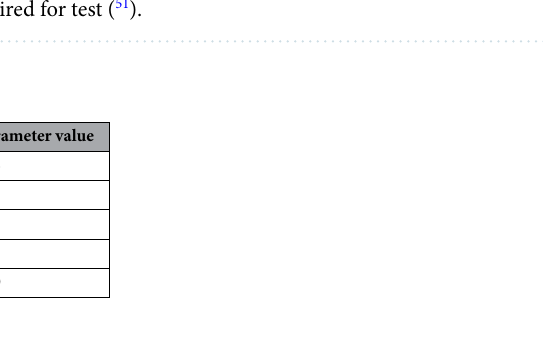
Table 2. Summarizing of parameters required for test ( 51 ).